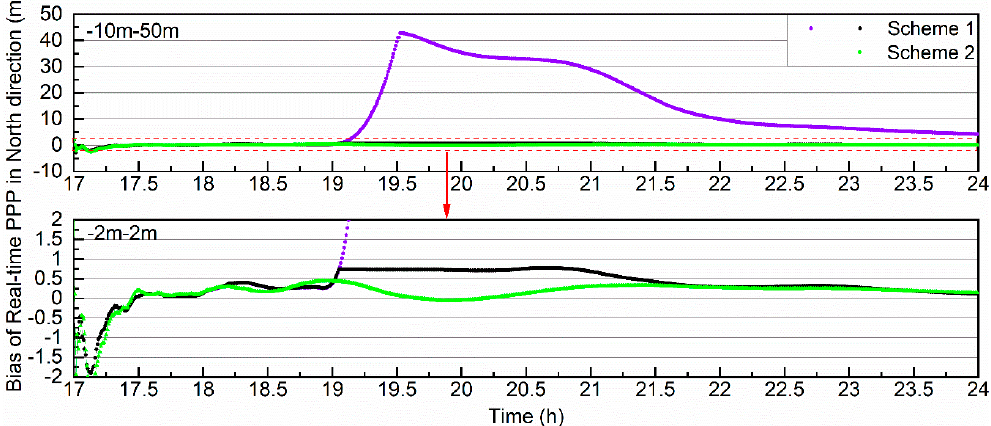
Figure 11. Bias of real-time PPP in the east.